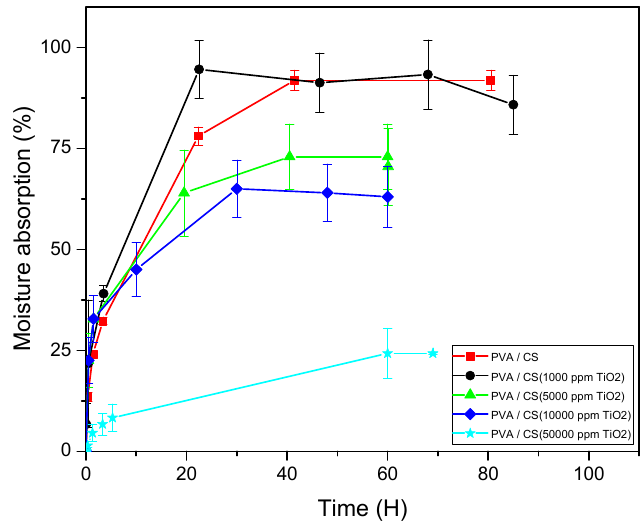
Figure 3. Moisture absorption isotherms for membranes with different TiO 2 contents.